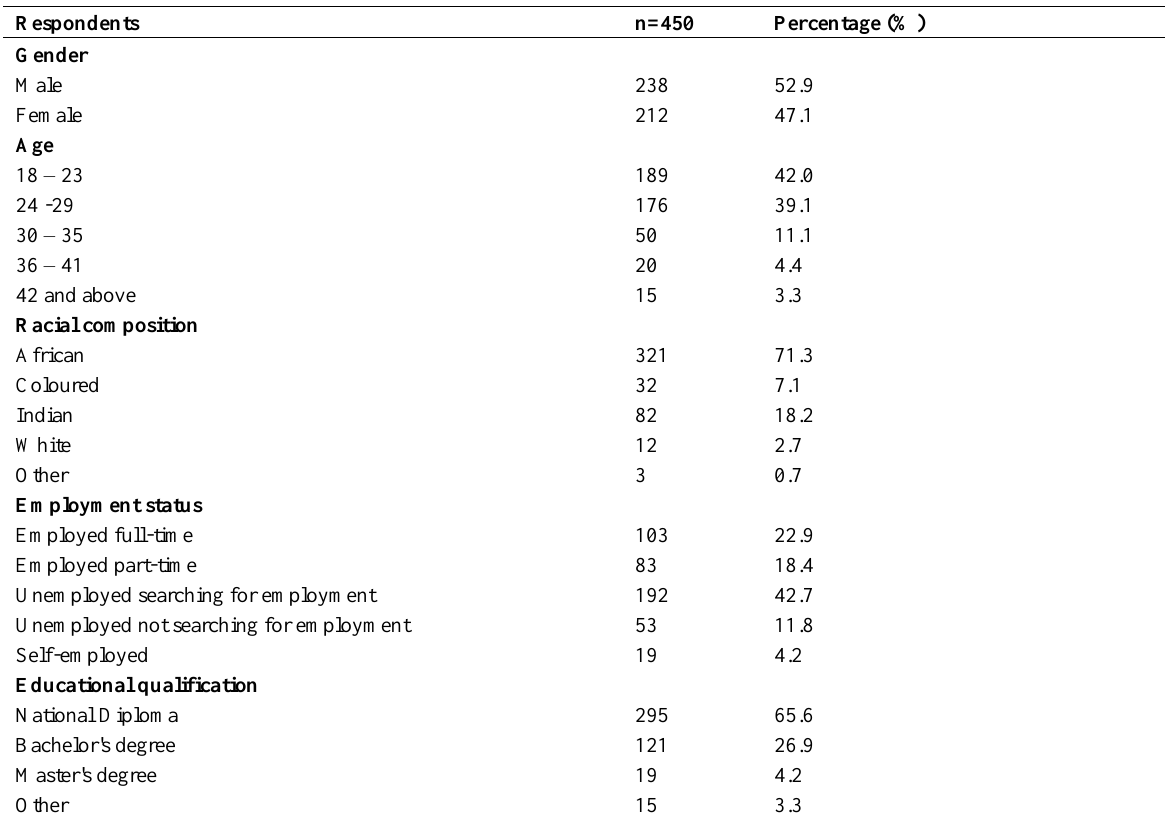
Table 1: Biographical profile of